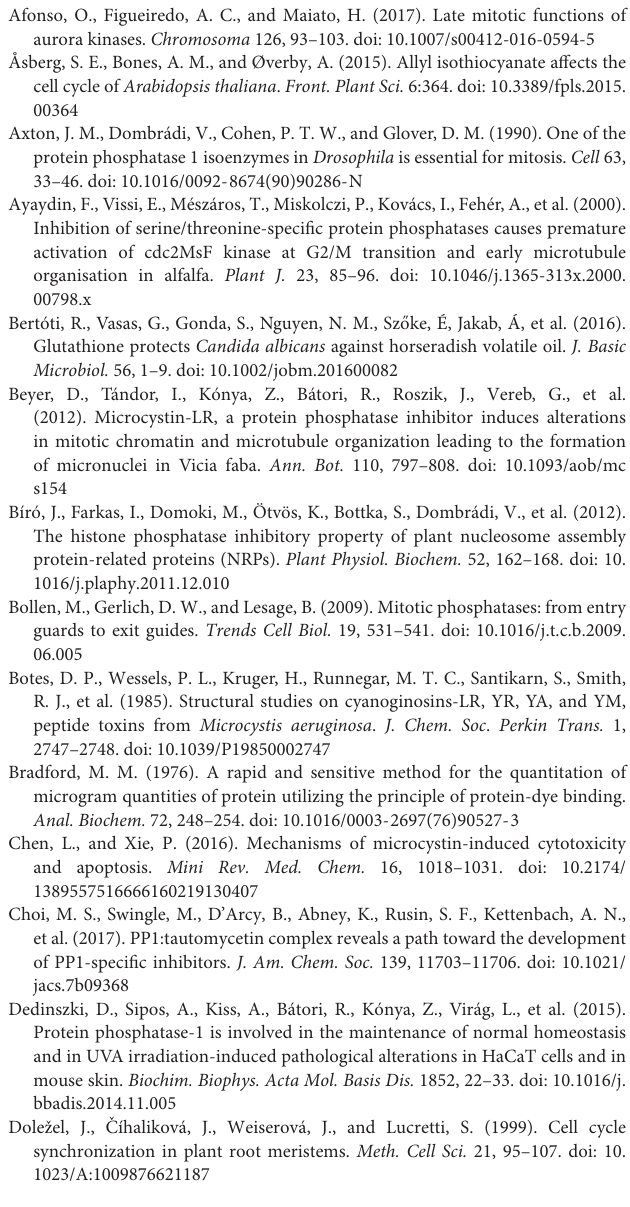
FIGURE S2 | Telophase chromatin from a lateral root tip meristem treated with 10 µ M MCY-LR, showing a lagging chromosome (arrow). Scalebar: 10 µ m. FIGURE S3 | Effects of 10 µ M AITC, 10 µ M MCY-LR and their combination on the development of abnormal metaphase spindles: percentage of abnormal spindles out of total metaphase spindles at different metabolite treatments. ∗ Significant differences of treatments to controls ( P < 0.05), n ≥ 12. FIGURE S4 | Effects of AITC and MCY-LR on the accumulation of reactive oxygen species (ROS) in V. faba lateral root tips. ROS was detected by DCFH-DA staining. n ≥ 12.